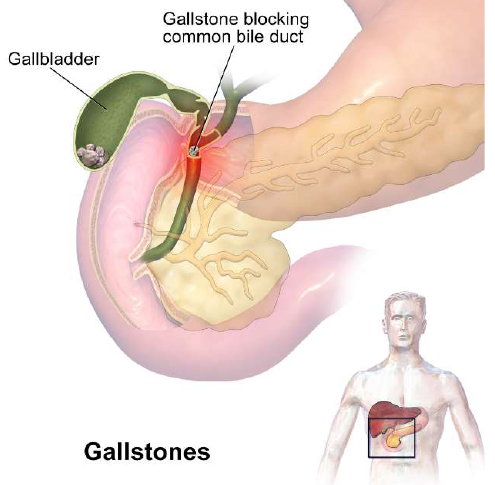
Figure 1. Graphic representation of the human gallbladder and the liver.